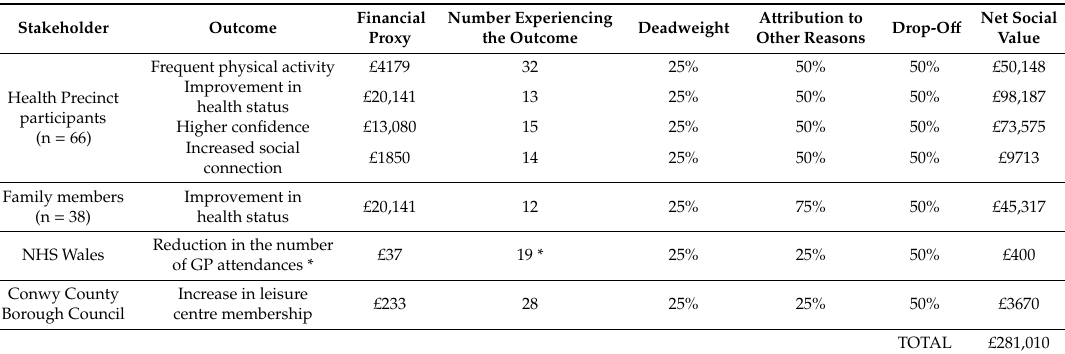
Table 3. Social value generated by each stakeholder